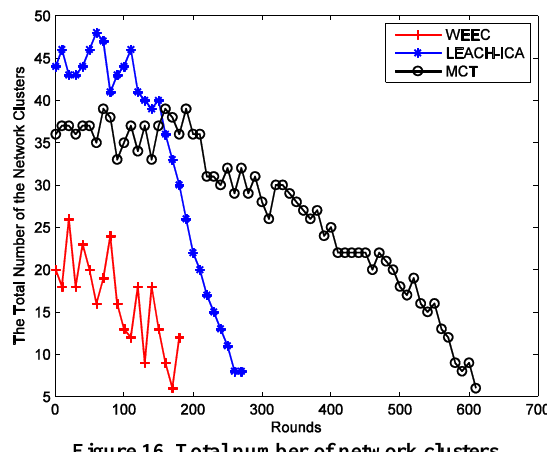
Figure 18. Total communication energy of ordinary sensors.